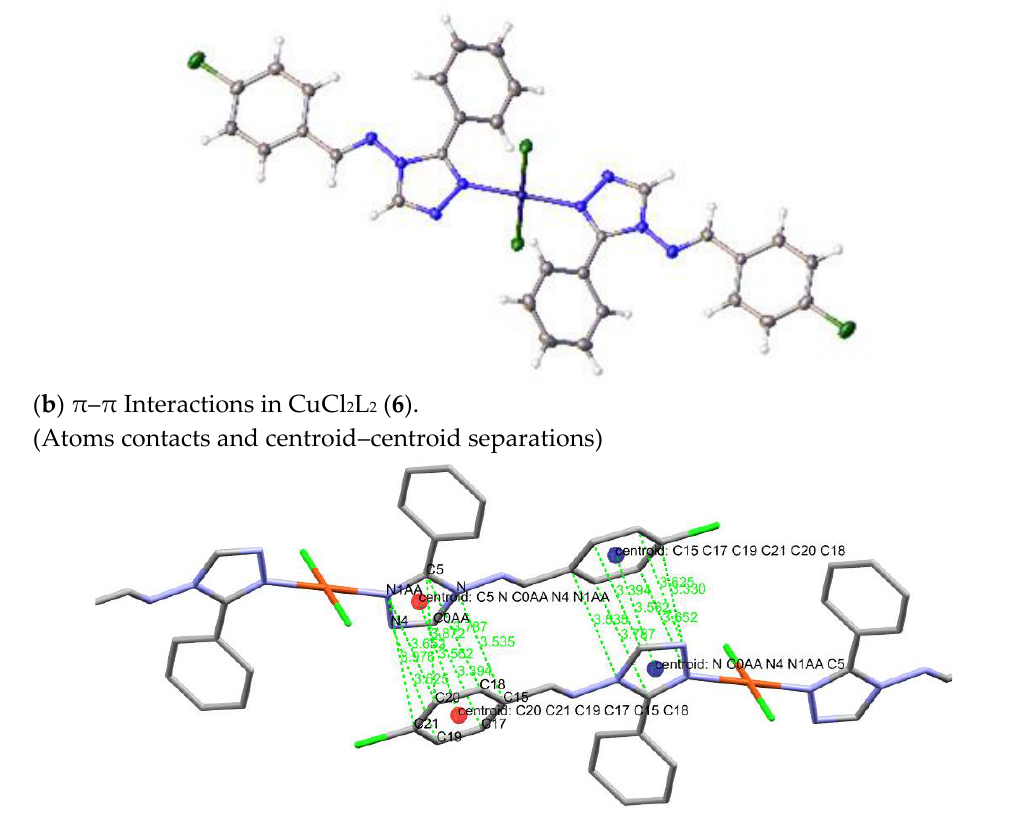
Figure 4. X-ray structure and structural features for square planar trans-CuCl 2 L 2 6 . Intermolecular H-bonds govern the supramolecular structure of the copper complex ( 6 ). Both chloride ions and nitrogen N(4) atoms of triazoles are involved in hydrogen bonds with CH groups (Figure 4b). For the D – H···A H-bond systems, C(0AA)- H(0A)….Cl(2A) an d C(12)- H(12)….Cl(2A), the distances d (D···A) are 3.549 and 3.735 (Å ) and the angles (DHA) are 167.99 and 163.61 (°), respectively. While for the H-bonds C(18)- H(18)….N(4), the distance is 3.333 (Å) and the angle is 150.63 (°). The π – π